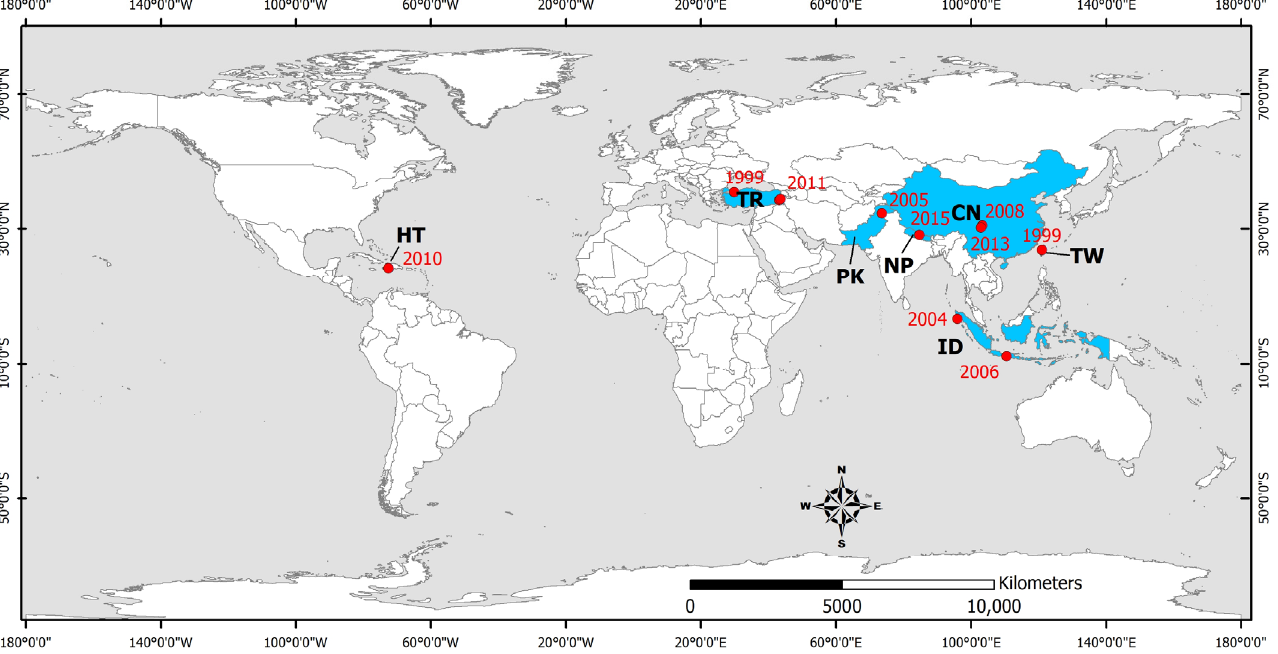
Figure 5. Countries affected by earthquake-triggered wound and skin infections. HT: Haiti, TR: Turkey, PK: Pakistan, NP: Nepal, CN: China, ID: Indonesia. The epicenters of the studied earthquakes are also illustrated (red dots), along with the occurrence year (red numbers). Table 5. Wound and skin infectious diseases transmitted during the post-earthquake period in earthquake-affected areas.